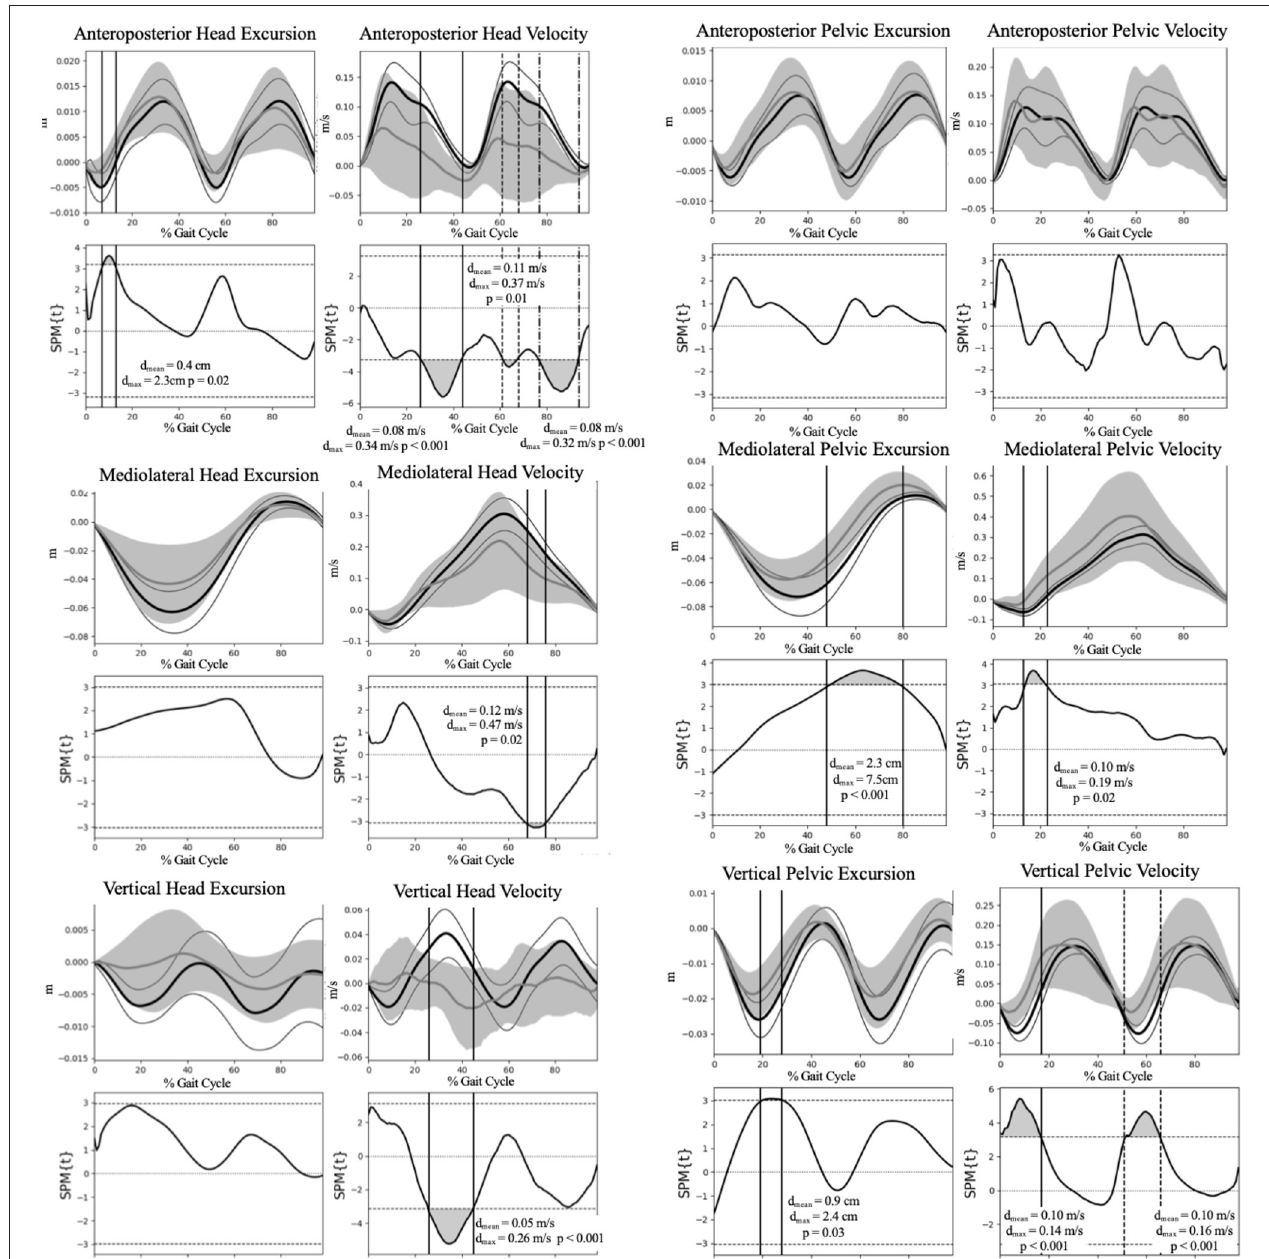
FIGURE 3 | Group comparison of the head and pelvis excursion and velocity during gait. Group means and 95% confidence interval cloud for the Vestibular (gray mean line and confidence interval cloud) and Control (black mean line and white confidence interval cloud) groups are depicted. d max , maximum difference between groups; d mean , mean difference between groups; SPM, Statistical Parametric Mapping.